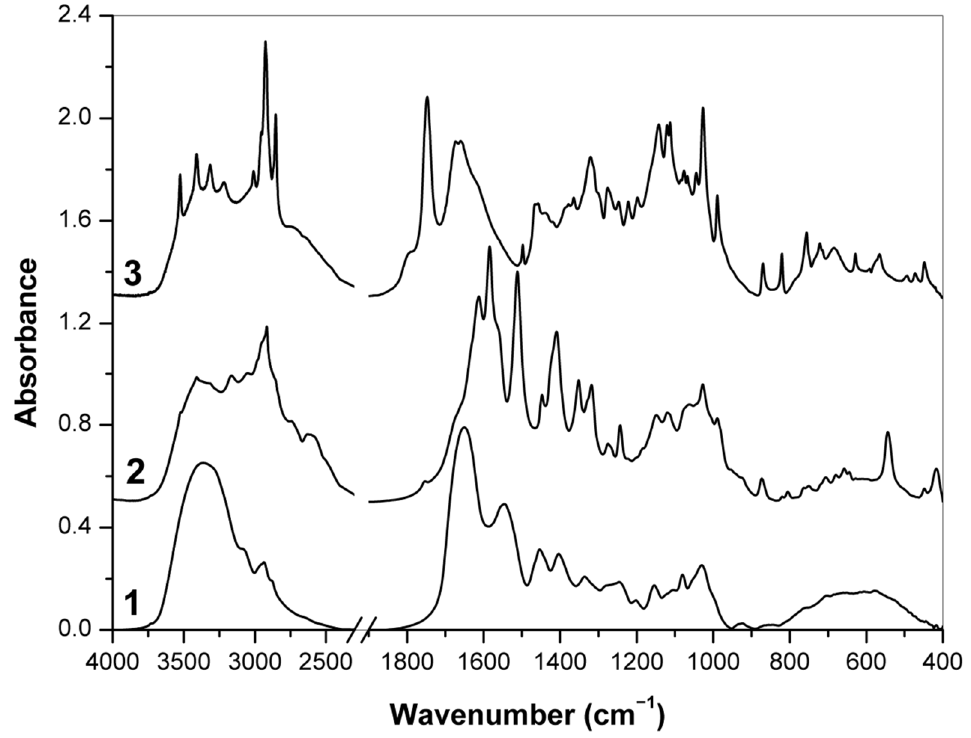
Figure 4. FT-IR spectra of supplements 1, 2 and 3 (in the latter case, capsule content).